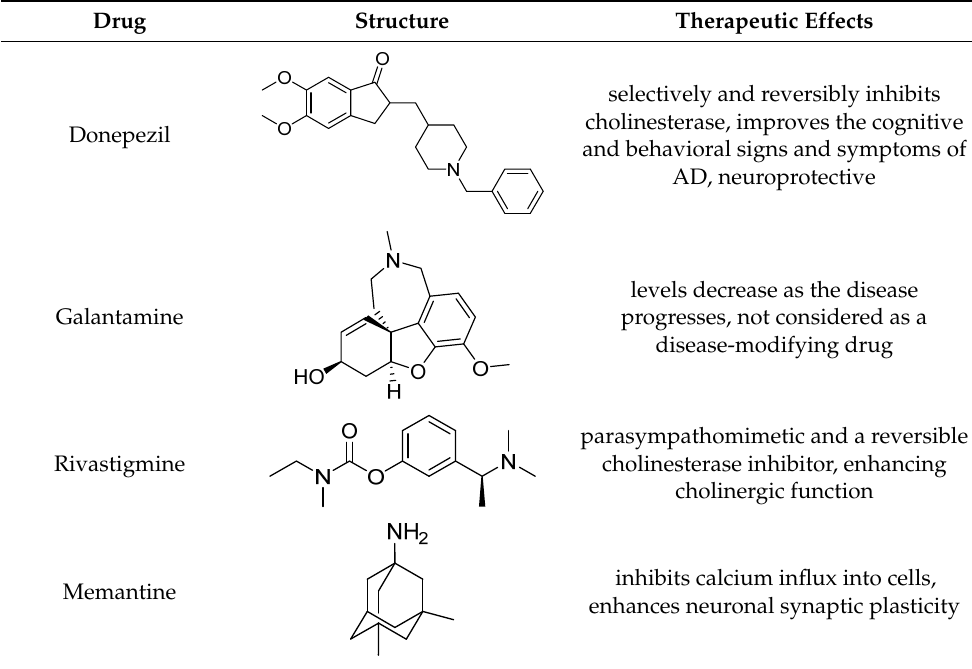
Table 1. FDA-approved drugs to improve cognitive functions.